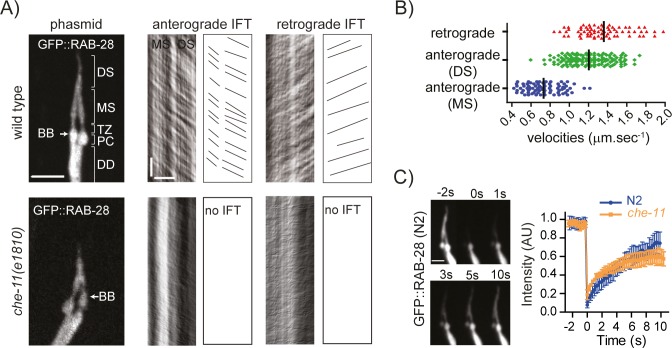
RAB-28 undergoes IFT.(A, B) Representative images of phasmid cilia (left) from N2 wild type and che-11(e1810) worms expressing GFP::RAB-28, together with corresponding kymographs and kymograph schematics derived from time-lapse imaging. Distribution plot (and mean values) in B shows kymography-determined anterograde and retrograde GFP::RAB-28 velocities from wild type worms. MS; middle segment, DS; distal segment, PC; periciliary membrane compartment, DD; distal dendrite. Scale bars; 3 μm (phasmid image; and horizontal bar on kymographs); 3 seconds (vertical bar on kymographs). (C) Fluorescence recovery after photobleaching (FRAP) plots for GFP::RAB-28 in the phasmid neurons of N2 and che-11(e1810) mutant worms. GFP::RAB-28 also undergoes free diffusion in wild-type (N2) and che-11 IFT mutant animals. Ciliary GFP signals bleached at time 0. Intensity measurements normalised to pre-bleach levels. Curves derived from 3 separate FRAP experiments. Error bars; SEM. Images taken from a representative FRAP experiment in N2 wild type worms. s; seconds. Scale bar; 2 μm.